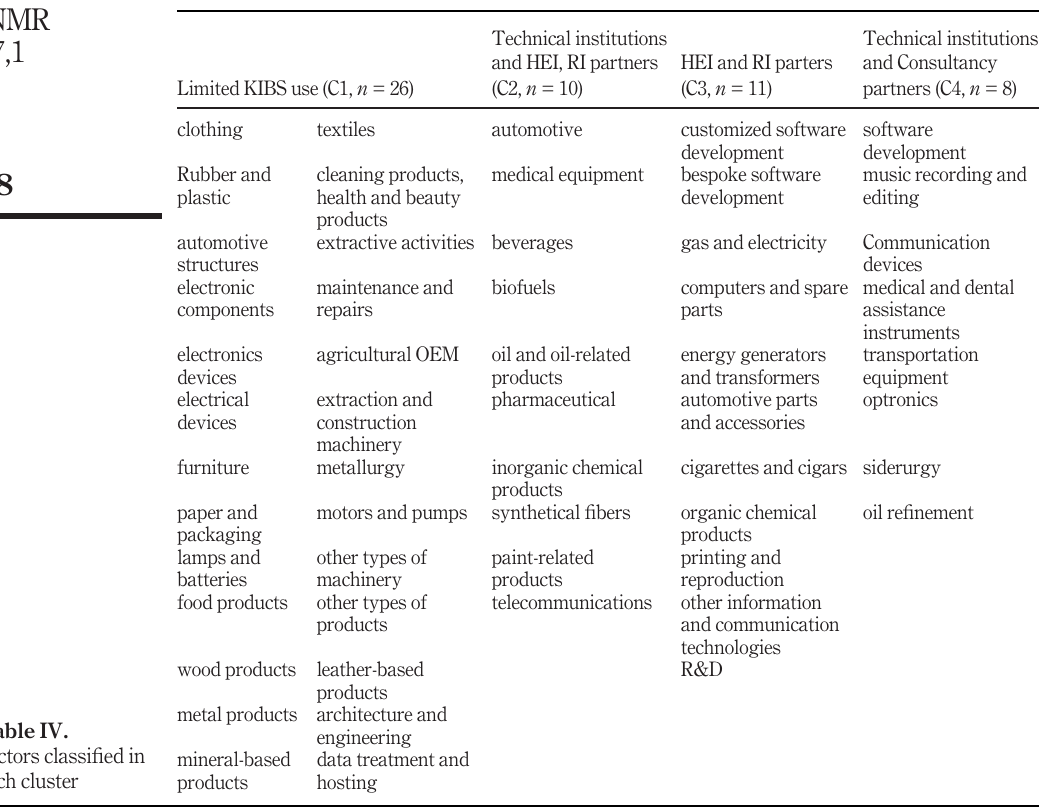
Table IV. Sectors classi fi ed in each cluster